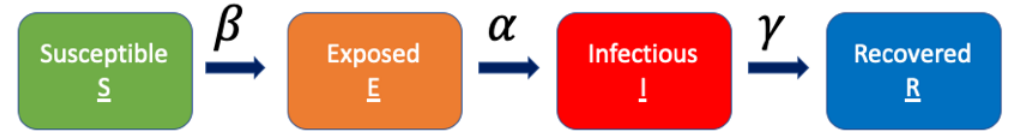
Figure 5. SEIR model with the four compartments and their relationships.